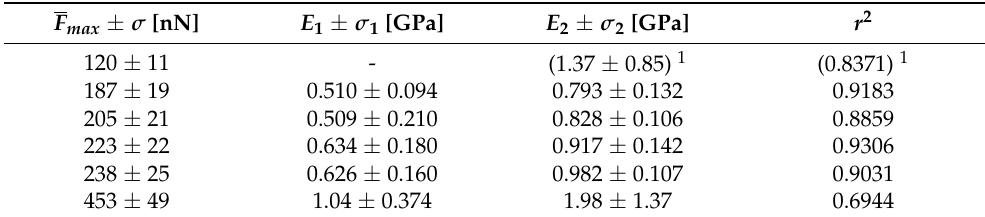
Table 1. Means and standard deviations calculated from the two-Gaussian fittings of the distributions of moduli extracted from the